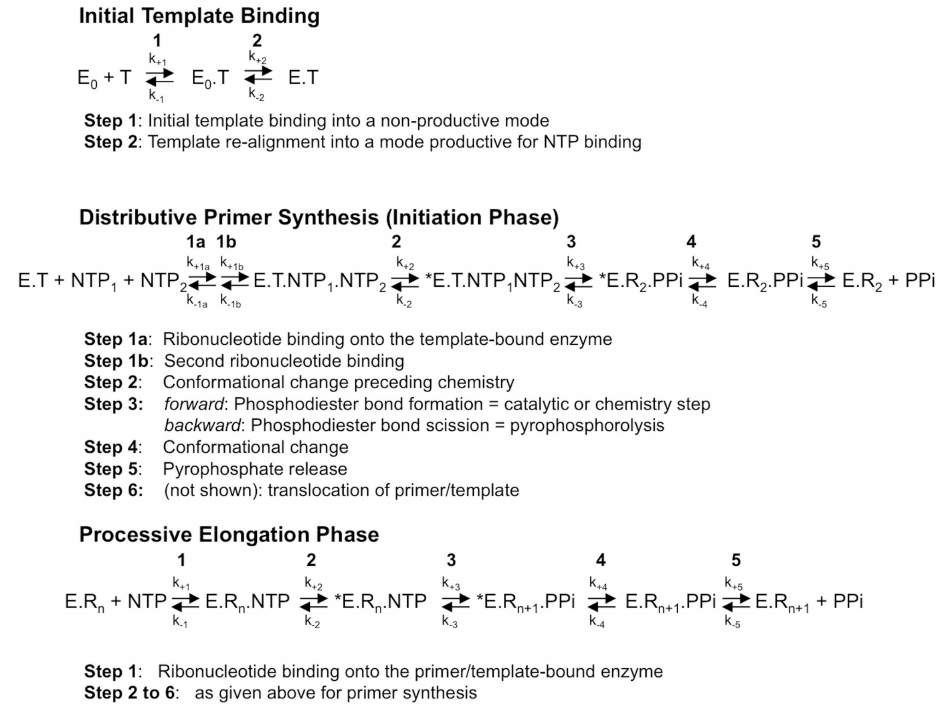
Figure 1. The mechanism of RNA synthesis by a viral de novo initiating RdRp. Although primer synthesis can be template-independent in flaviviruses, the current general model for de novo RNA synthesis by viral RdRp including Flavivirus RdRp is best described with three distinct phases, that of template binding into a productive mode (upper scheme), followed by primer synthesis (here, a di-ribonucleotide, middle scheme) and primer elongation (lower scheme). The constants k +1 to k +5 and k − 1 to k − 5 represent the forward and backward kinetic constants of each individual reversible reaction, respectively. The constants k +1 to k +5 and k − 1 to k − 5 for each phase are not equivalent, as they do not represent the same reactions. T, template; E 0 , free enzyme; E, enzyme bound to the template under a productive mode for nucleotide binding; *E, catalytically competent enzyme for nucleotide incorporation; NTP, correct (i.e., template-complementary) ribonucleotide 5 (cid:48) -triphosphate; R n , RNA made of the primer of n nucleosides annealed to the template. Only the dinucleotide primer synthesis step is shown, primer synthesis may comprise more steps; PPi: pyrophosphate.